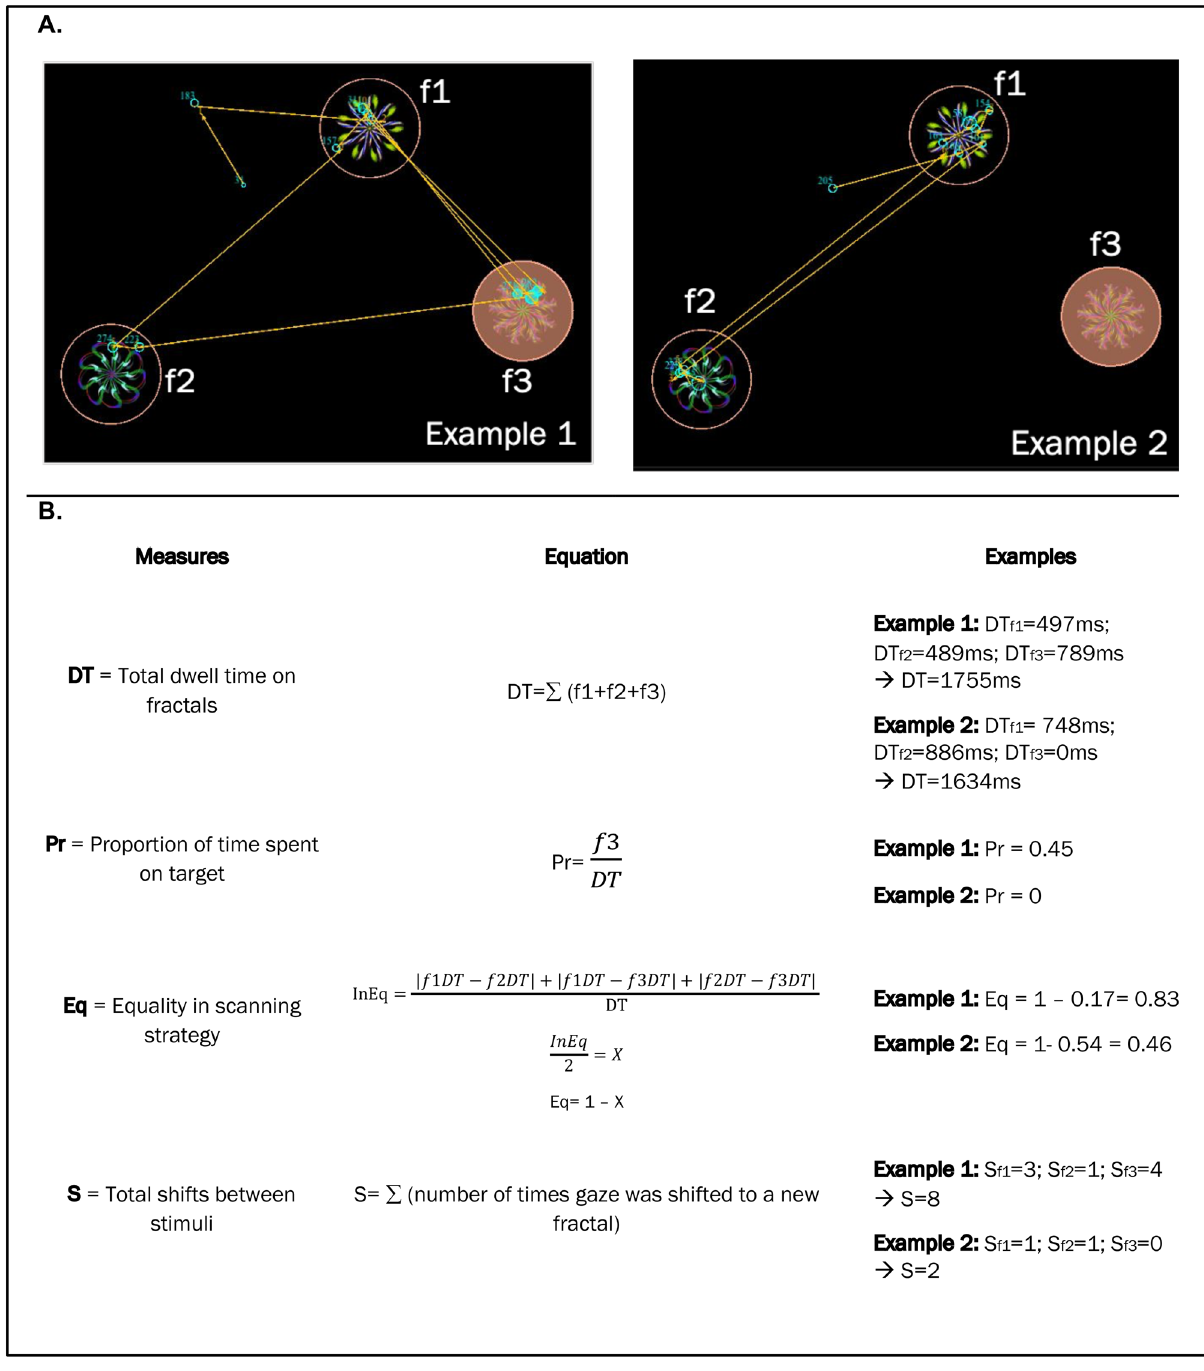
Figure 5. ( a ) Example of the stimuli. Highlighted fractal represents the target (f3), the identity of which was not known to the participant at the time of viewing. Cyan circles show fixations, yellow arrows indicate saccades and the circles around each fractal outline the region of interest. ( b ) Definition of visual exploration measures with examples from sample array. InEq = Inequality. f1, f2 and f3 are fractal 1, 2, and 3 respectively. DT f1 , DT f2 and DT f3 are the dwell times on fractal 1, 2, and 3 respectively. S f1 , S f2 and S f3 are the total shifts on fractal 1, 2 and 3